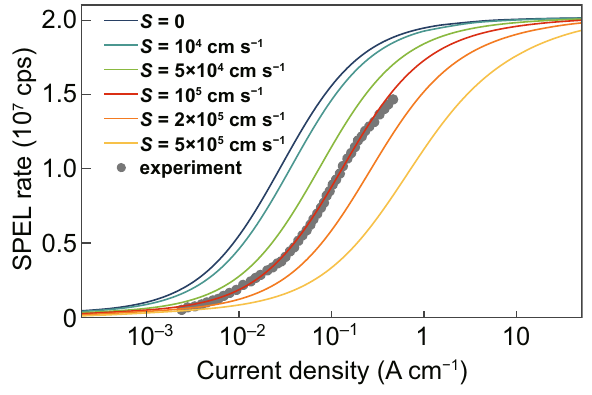
Fig. 3 Simulated SPEL rate versus injection current density per unit diode width for the color center located near the SiO 2 /4H-SiC interface in the n − -type region at a distance of 3 μm from the p + –n − junction and 10 nm from SiO 2 /4H-SiC interface for different surface recombination velocities S at the SiO 2 /4H-SiC interface. The electron capture cross section by a neutrally charged color center c n0 is equal to 7.2 × 10 −9 cm 3 s